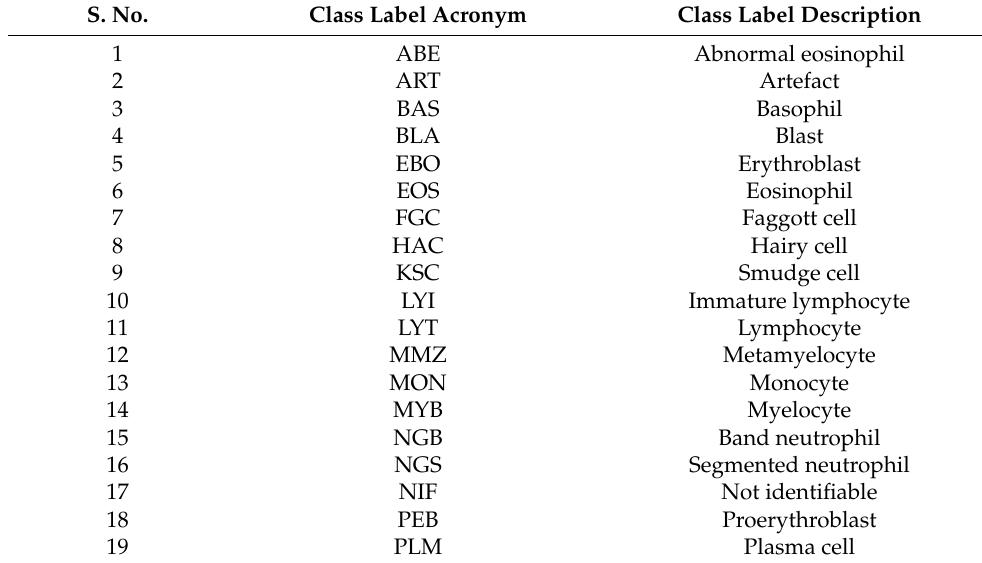
Table 2. Description of 21 different class labels in the dataset. S.